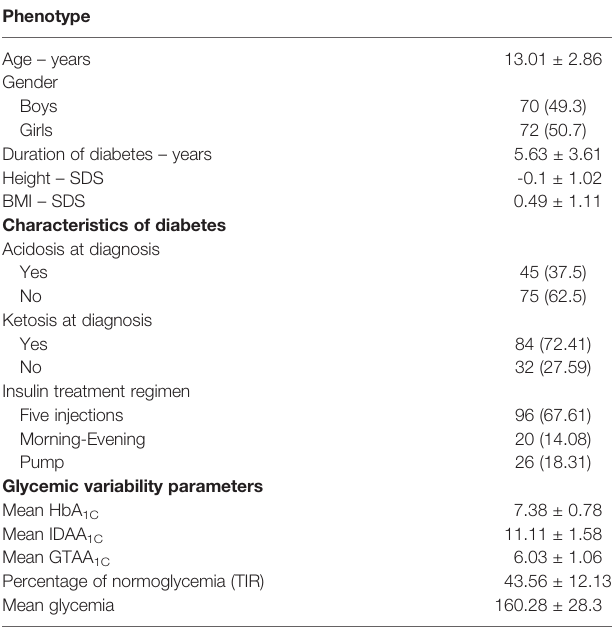
TABLE 1 | Characteristics of the EPHICA